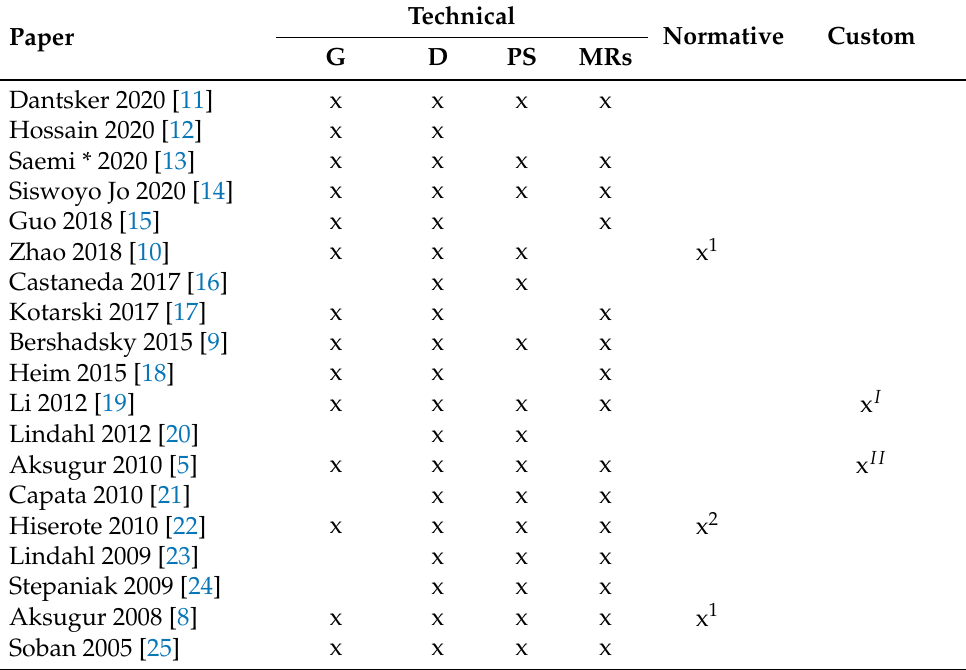
Table 2. Classification of the constraints analyzed in each paper within the functional design, sizing category, among technical, normative, and custom sets. For the technical constraints, the distinction among the four subsets of Geometry (G), Dynamics (D), Power Supply (PS), and Mission Requirements (MRs) is